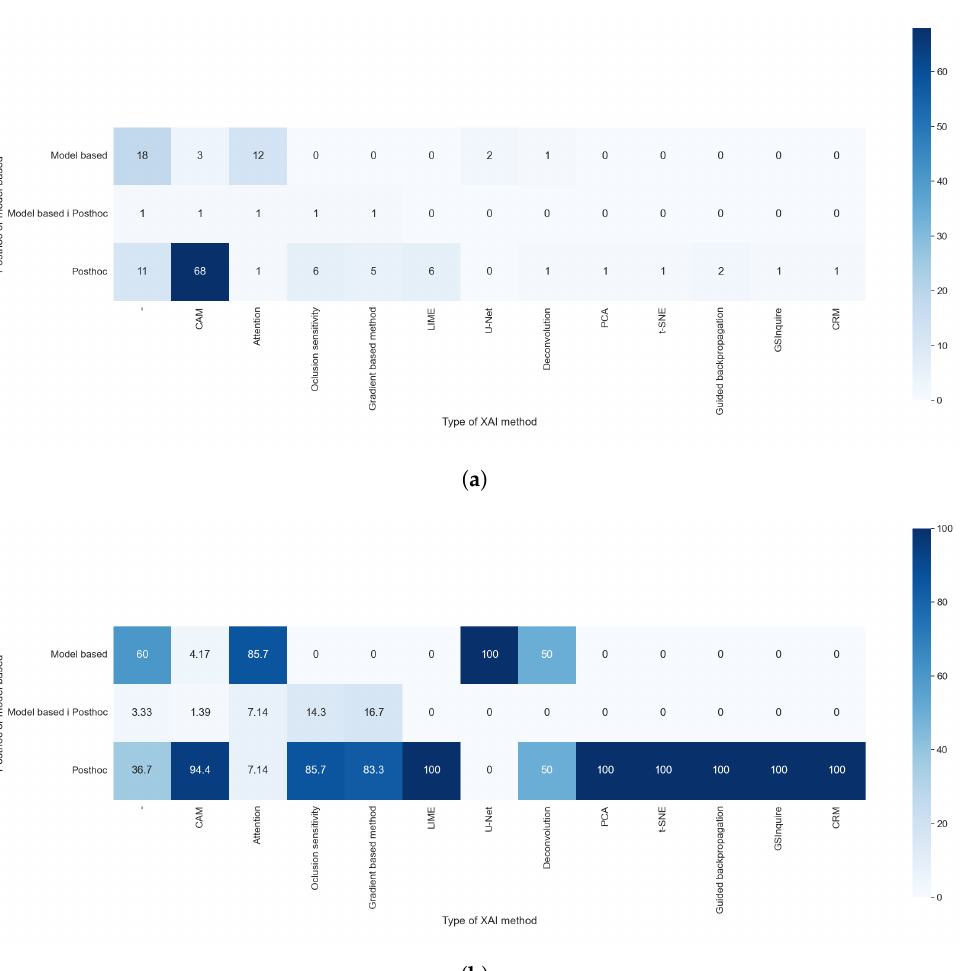
Figure 14. Heat maps comparing the results of RQ5 and RQ6. All articles that did not indicate which type of XAI method used are shown. ( a ) In absolute values; ( b ) normalized results by column, values in